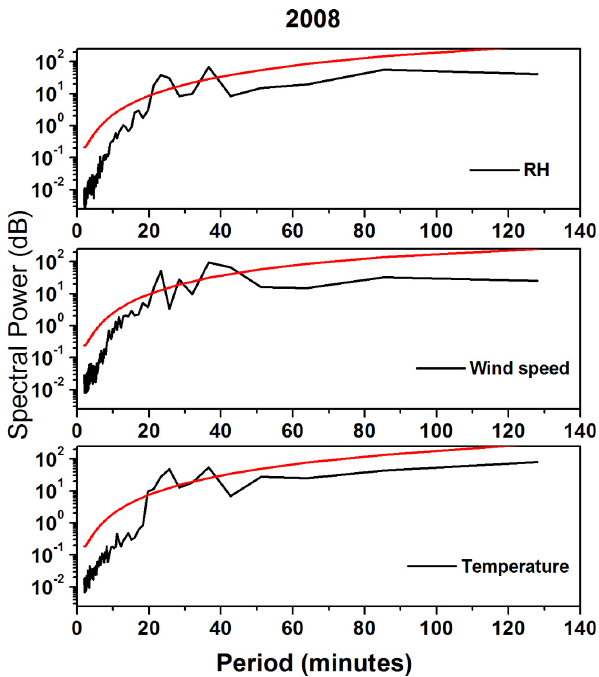
Fig. 5. Composite spectral power for the surface temperature (bot- tom), surface wind speed (middle) and relative humidity (top) for all the experimental days in